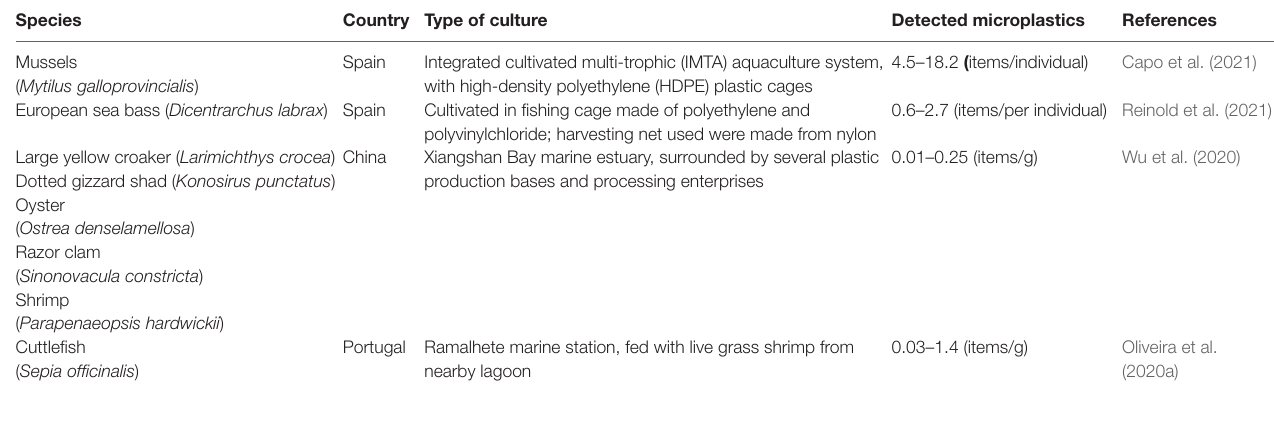
TABLE 3C | Detection of microplastics in aquaculture